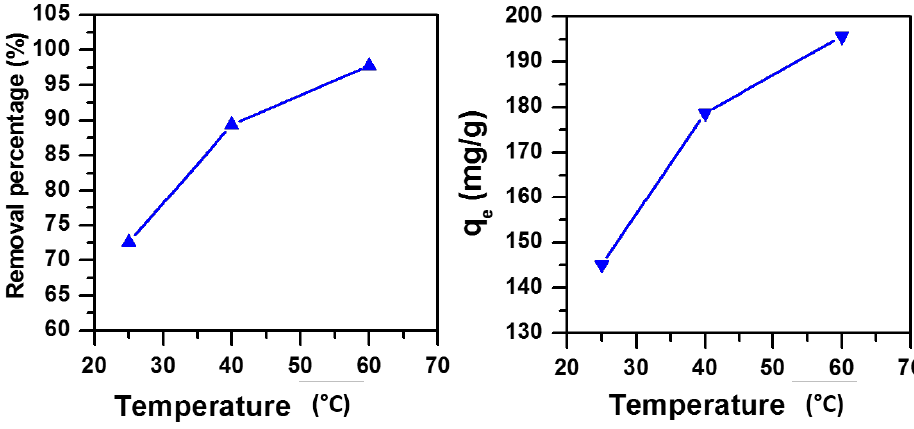
Figure 6. Effect of temperature on the removal efficiency of MB using MNS-4 (C i = 2000 ppm, m adsorbent = 1 g, contact time = 30 min, pH = 11).